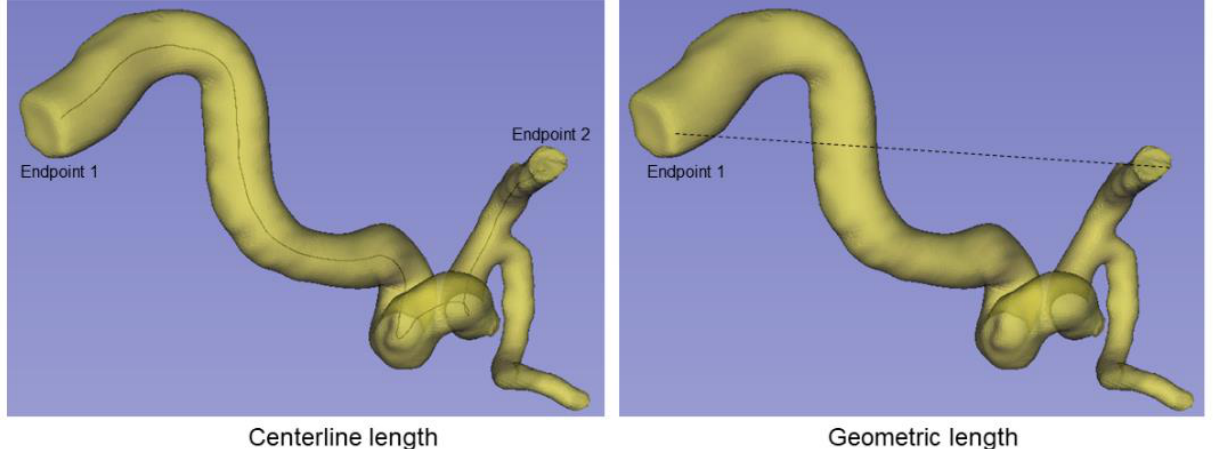
Figure 1. Estimation of tortuosity of vessel segment. ( Left ): Centerline represents the ICA to MCA ends. ( Right ): Geometric distance (shortest) between ICA to MCA ends.